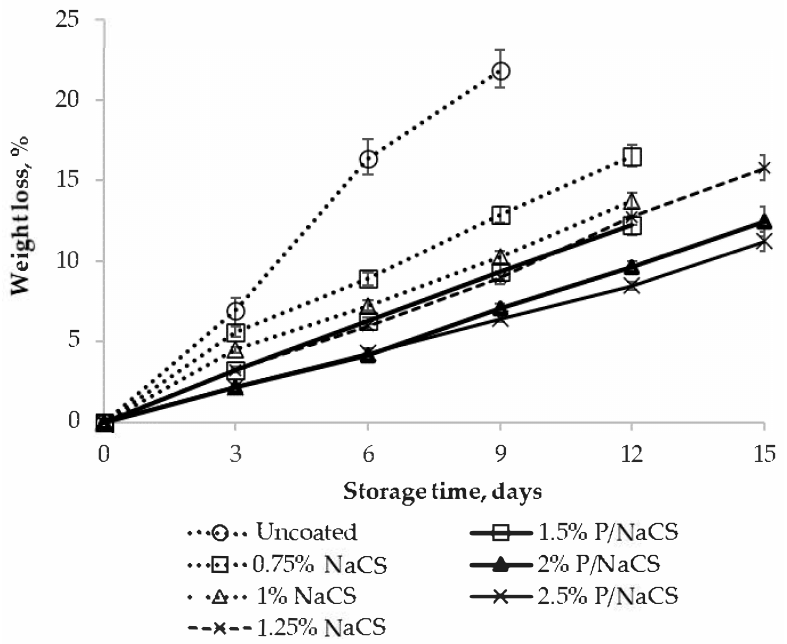
Figure 2. Effect of coating on the weight loss of mango fruits. Numbers are the mean ± standard errors of three replications. Note: P/NaCS means pectin plus nanochitosan with ratio 50:50 for all